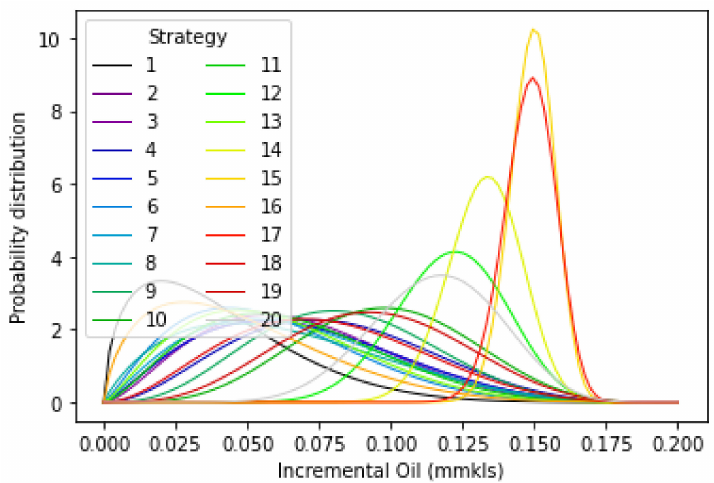
Figure 16. Incremental oil distributions for each injection location chosen after 400 iterations.